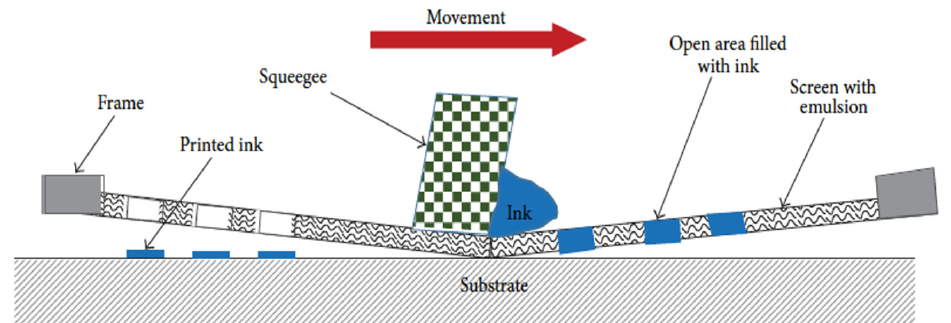
Figure 15. Schematic of screen printing.